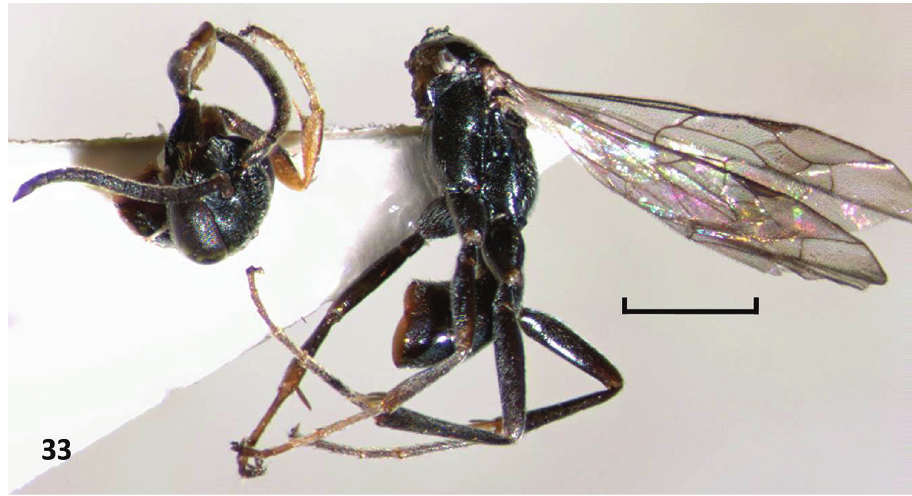
Figure 33. Nipponodipogon shimizui Loktionov, Lelej & Xu, sp. n., male, paratype, habitus, lateral view. Scale bar 1